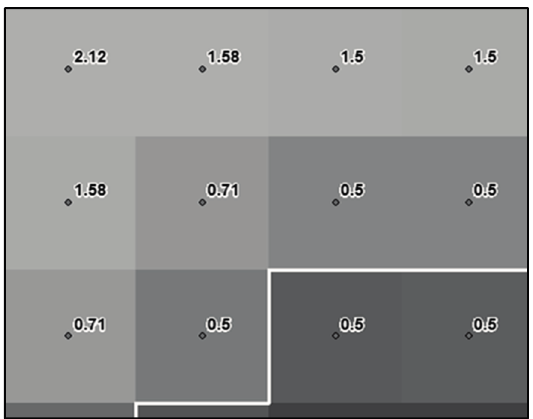
Figure 4. Euclidean distance, in pixel units, from each pixel’s center (gray point) to the nearest segment boundary (white line).